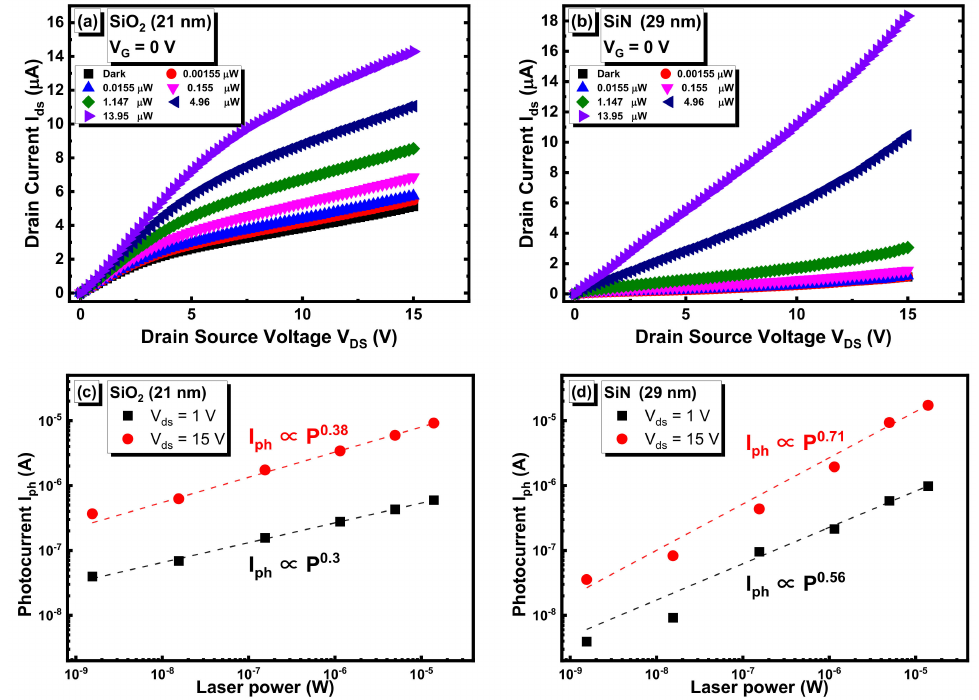
Figure 6. I d -V ds characteristics of the fabricated devices on ( a ) SiO 2 /Si substrates and ( b ) SiN/Si substrates, at different laser powers. ( c , d ) The photocurrent I ph as a function of the laser power at two polarization